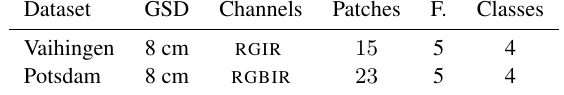
Table 1: Dataset properties. F.: Number of